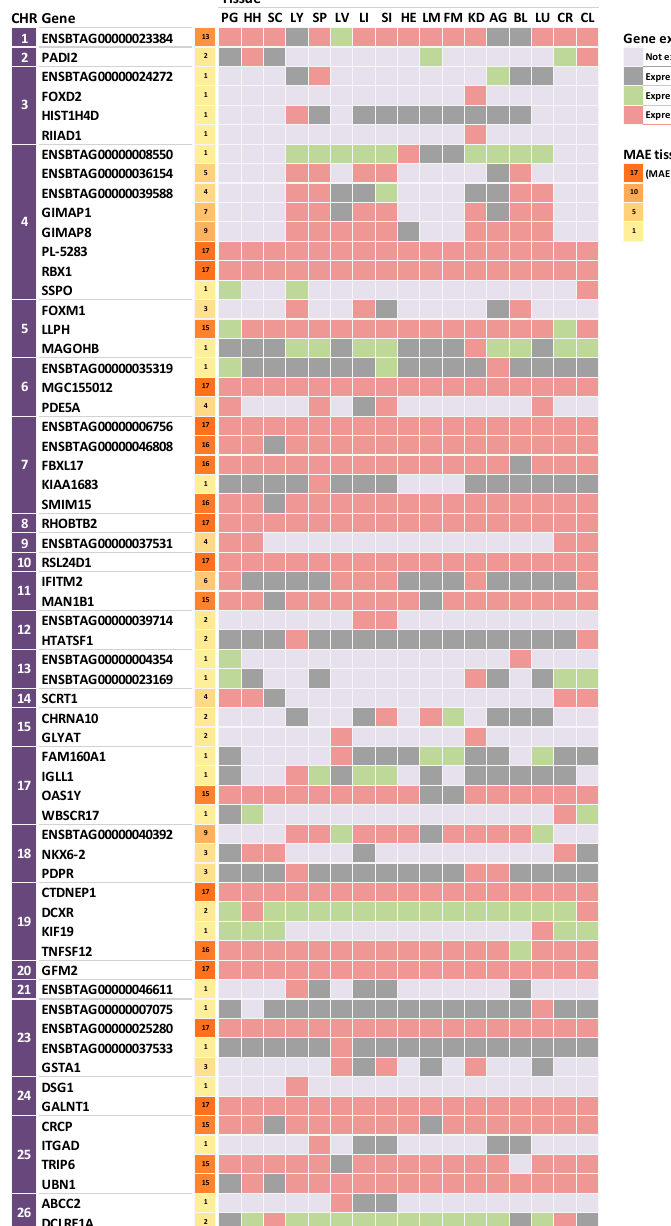
Figure 1. Monoallelic expression (MAE) of 62 genes in 17 tissues. The expression levels below FPKM 1 were considered as absence of expression and are represented by light grey squares. FPKM, fragments per Kilobase of exon per million fragments mapped; CHR, chromosome.